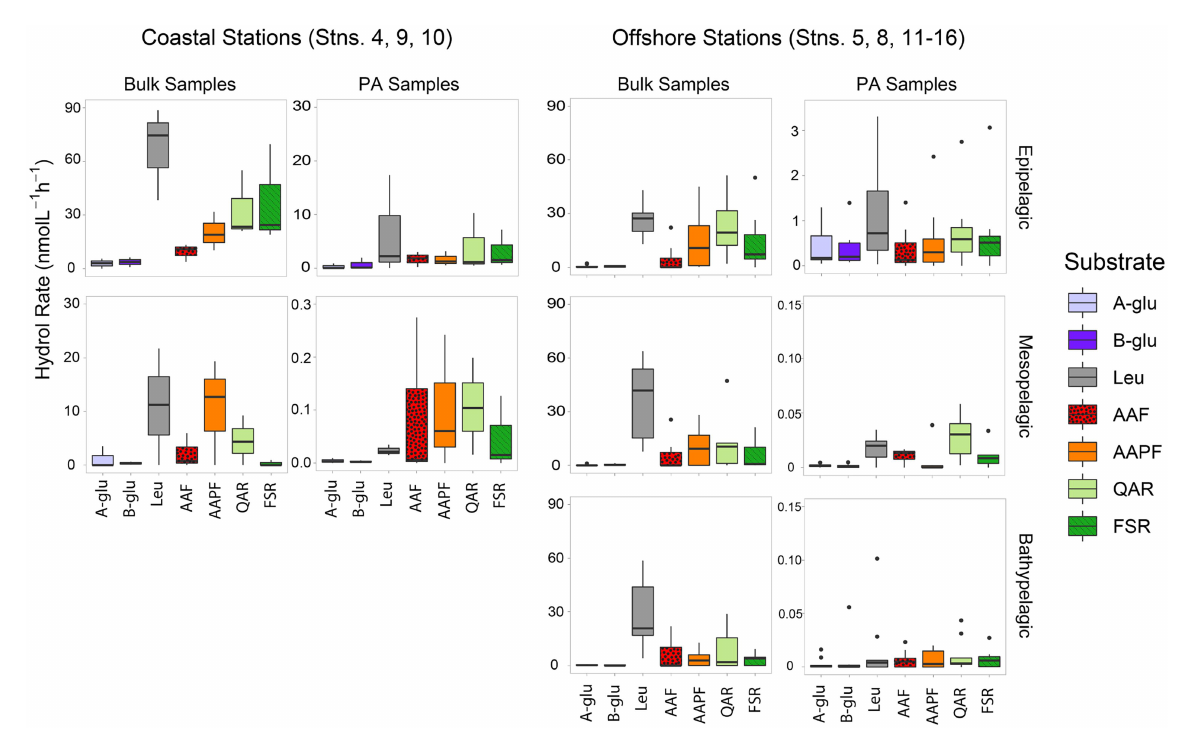
FIGURE 1 Box and whisker plot of glucosidase and peptidase activities of bulk and particle-associated (PA) water samples; line in middle represents median value, top and bottom of the box represent the upper and lower quartile, respectively, ends of ‘whiskers’ represent lowest and highest values (dots: outliers). Coastal stations include Stns. 4, 9, and 10, and offshore stations include Stns. 5, 8, and 11–16. A-glu, alpha-glucosidase; B-glu, beta- glucosidase; Leu, leucine aminopeptidase; AAF, alanine–alanine-phenylalanine-chymotrypsin; AAPF, alanine–alanine-proline-phenylalanine- chymotrypsin; QAR, glutamine-alanine-arginine-trypsin; FSR, phenylalanine-serine-arginine-trypsin. Note that the y-axis differs for bulk and PA samples at each